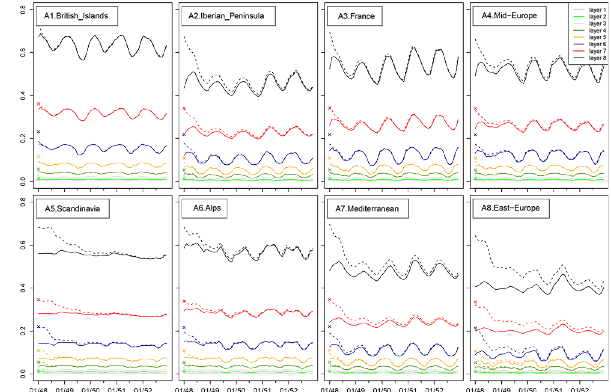
Figure 2. Soil moisture content [m] for the eight European sub- regions of Fig. 1. Crosses: initial value; dashed lines: monthly mean of spin up run; solid: monthly mean of the final (restarted) simula- tion. The colors belong to the soil